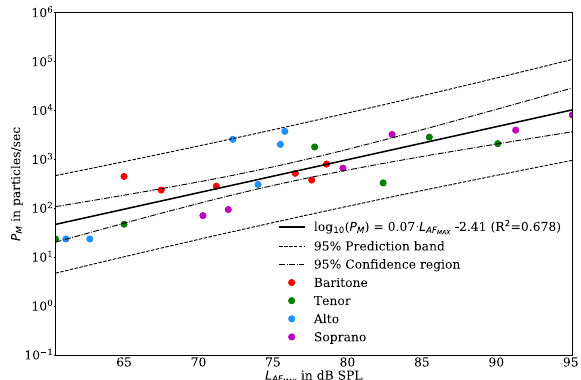
Figure 4. Relationship between emission rate P M and the maximum sound pressure level L AF MAX for the test conditions of sustained vowel /a ː / (Experiment II) for all three loudness conditions separated by voice classification including linear regression of the logarithmic emission rates (black line). For regression analysis, only medians of P M and L AF MAX of the five replications were used. (Figure created with matplotlib 3.2.1, http:// matpl otlib. org)